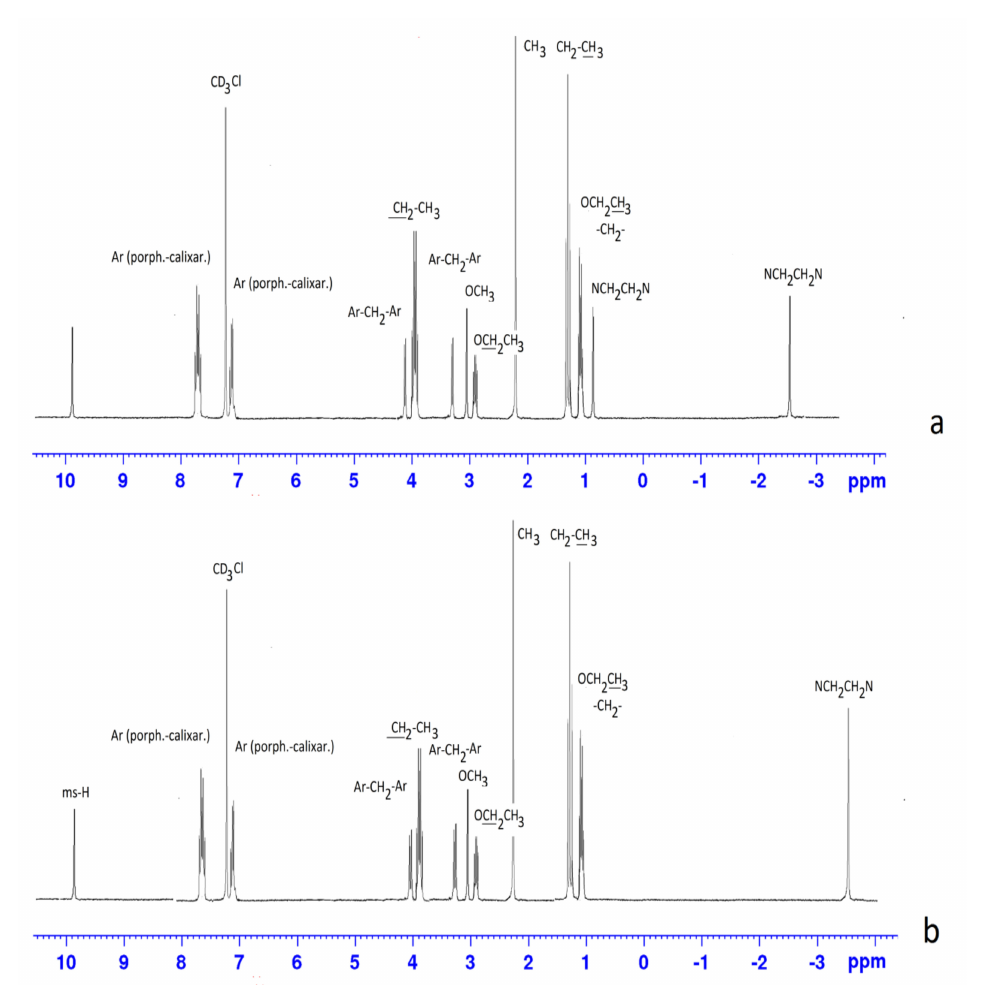
Figure 7. 1 H-NMR spectra of external ( 51 ) ( a ) and internal ( 53 ), ( b ) complexes in CDCl 3 (300 MHz, 298